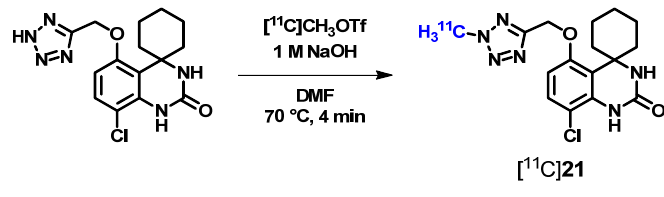
Scheme 9. Scheme 9. Radiosynthesis of [ 11 C] 21